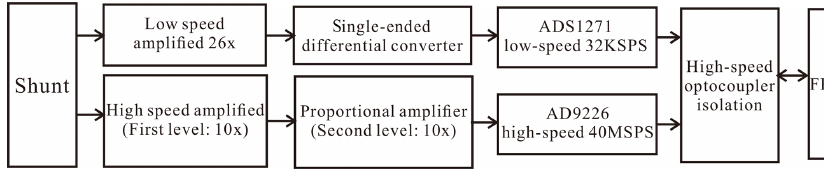
Figure 2. Block diagram of the conditioning process for current